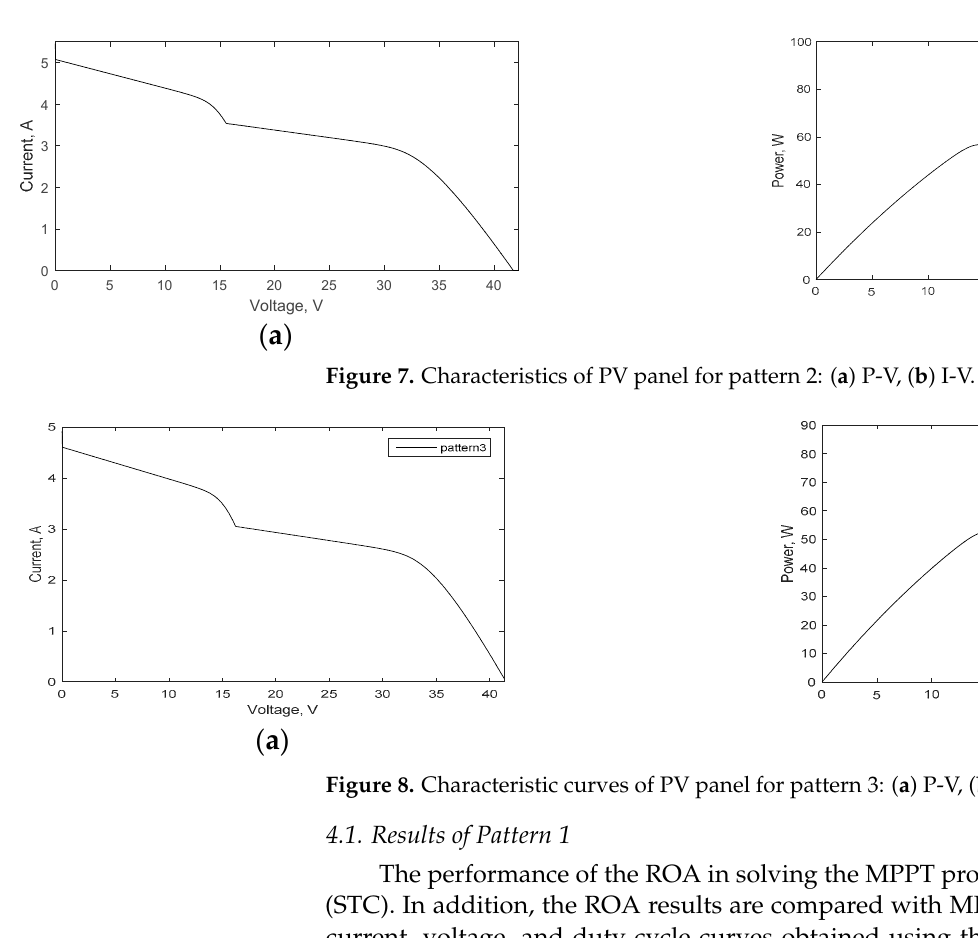
Figure 6. Characteristics of PV panel for pattern 1: ( a ) P-V, ( b ) I-V.